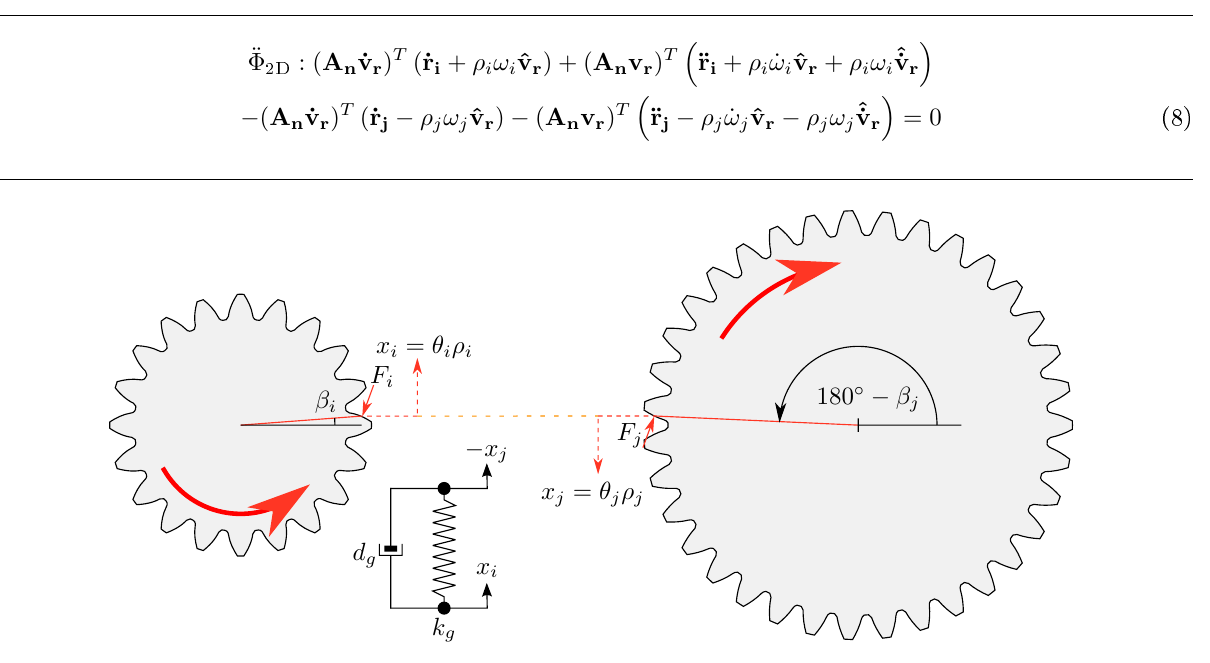
Figure 4: Illustration of spring k g and damper d g between two gears for a simpli(cid:28)ed spring/damper system. Gear tooth force is perpendicular to teeth